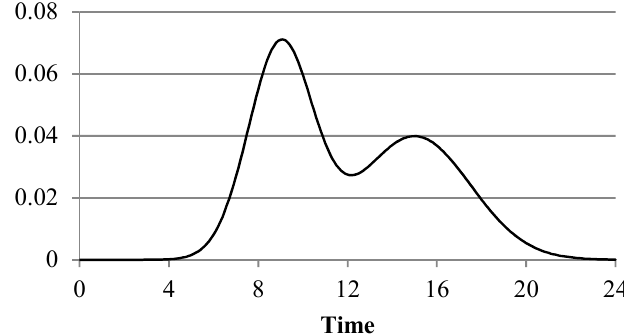
World Electric Vehicle Journal 2019 , 10 , x FOR PEER REVIEW Figure 2. Distribution of non-commuter electric vehicle (EV) departure time. Figure 2. Distribution of non-commuter electric vehicle (EV) departure time.